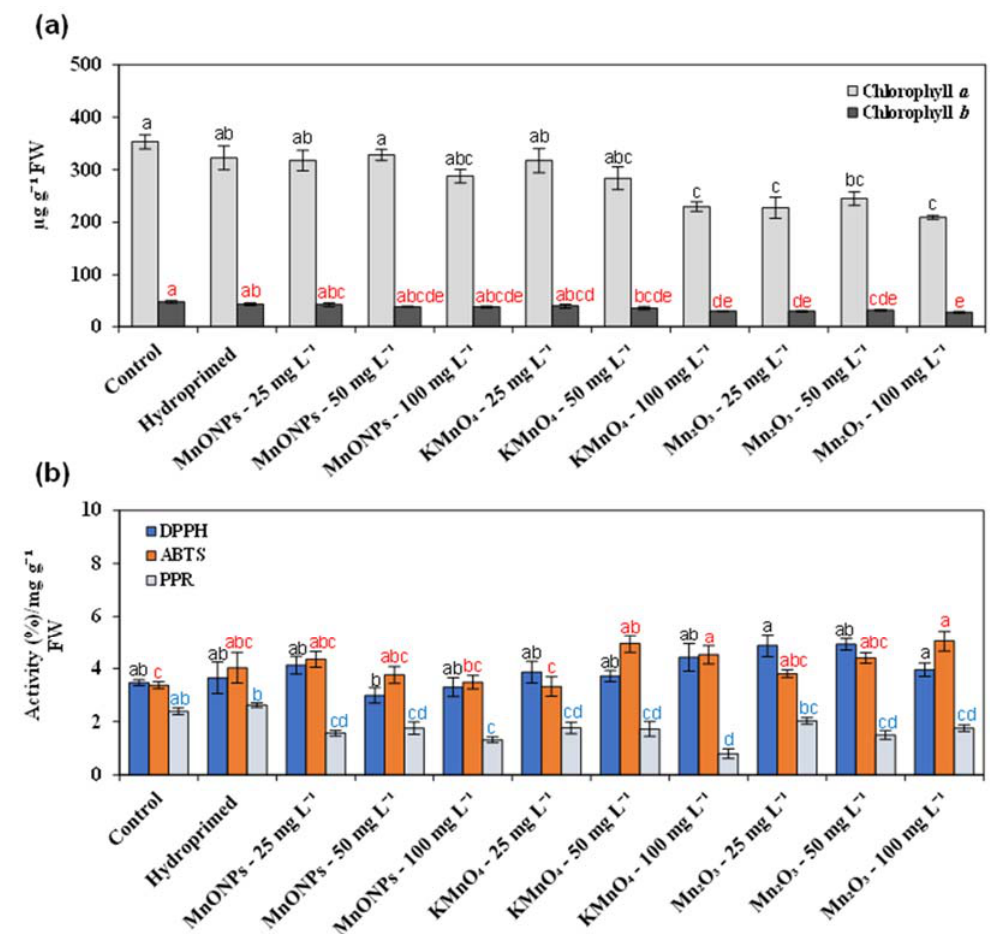
Figure 2. Comparative phytotoxicity of different seed priming treatments with MnO-NPs, KMnO 4, and Mn 2 O 3 in diploid watermelon seedlings. The effect of MnO-NPs, KMnO 4, and Mn 2 O 3 seed priming treatments (25, 50, and 100 mg · L − 1 ) on chlorophyll contents ( a ) and antioxidant activity levels in DPPH, ABTS, and PPR leaf disc assays ( b ). The post hoc test based significant differences ( p < 0.05) among different groups and assays are presented by different letters and colors.